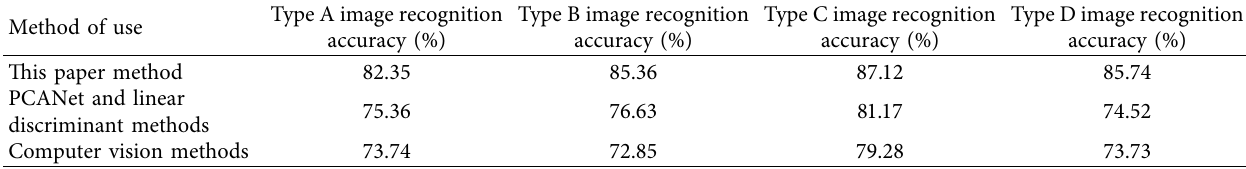
Table 3: Identification